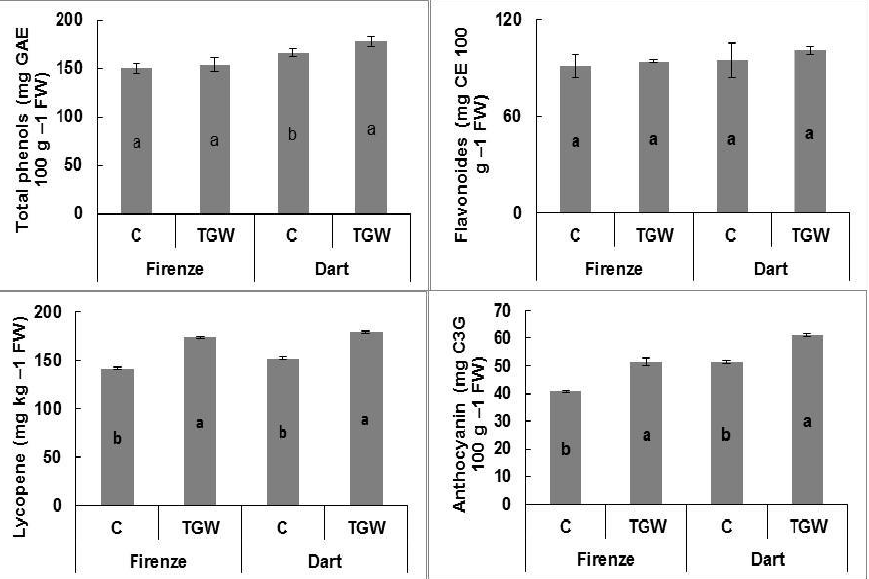
Figure 3. Changes in total phenolics, flavonoids, lycopene and anthocyanin concentrations of two tomato cultivars (Firenze and Dart) under two irrigation treatments (C: ground water and TGW: treated grey water). Values are means ± SE of n = 4, different lowercase letters indicate significant difference among treatments and different uppercase letters indicate significant difference between cultivars according to LSD test at p ≤